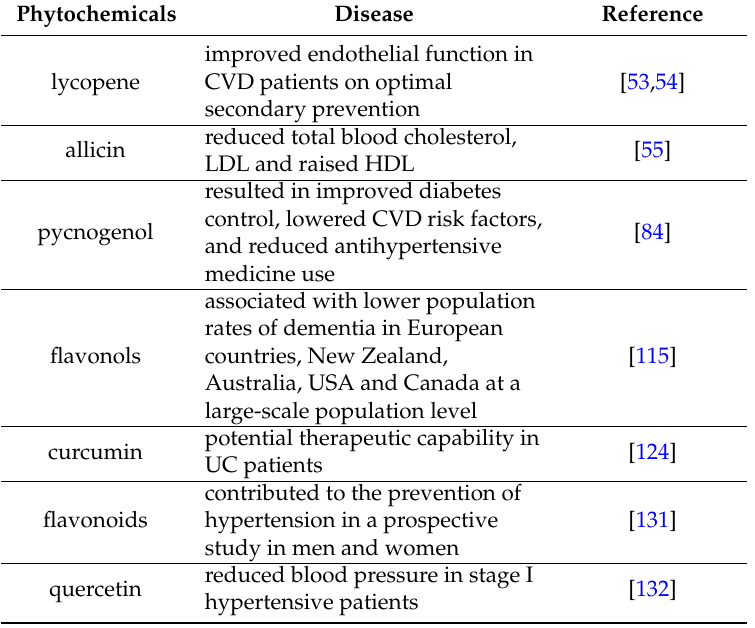
Table 2. Antioxidant phytochemicals showing preventive and/or therapeutic effect by human